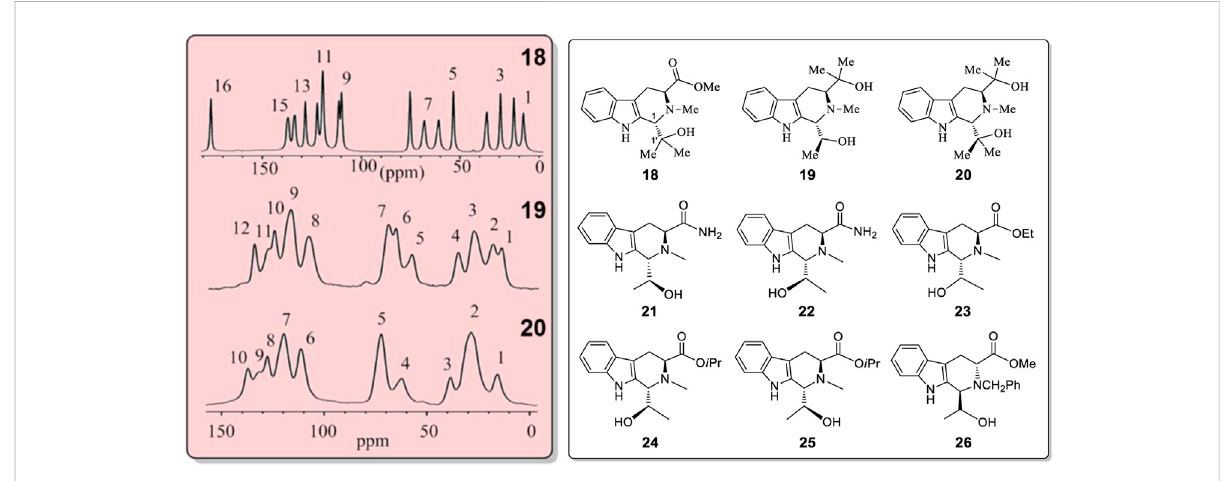
FIGURE 7 13 C CP-MAS NMR spectra for compounds 18, 19 and 20 in the solid state. Structures of 18 –